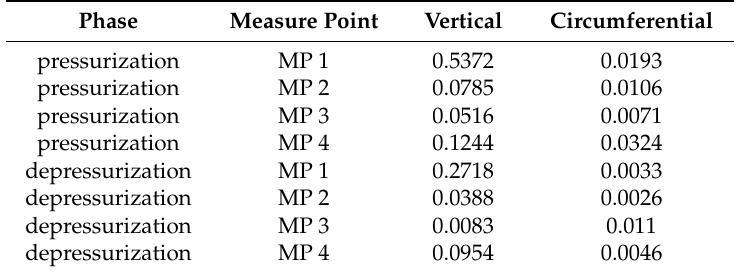
Table 3. The ratio of residual sum of squares (RSS) to total sum of squares (SYY). Phase Measure Point Vertical Circumferential pressurization MP 1 0.5372 0.0193 pressurization MP 2 0.0785 0.0106 pressurization MP 3